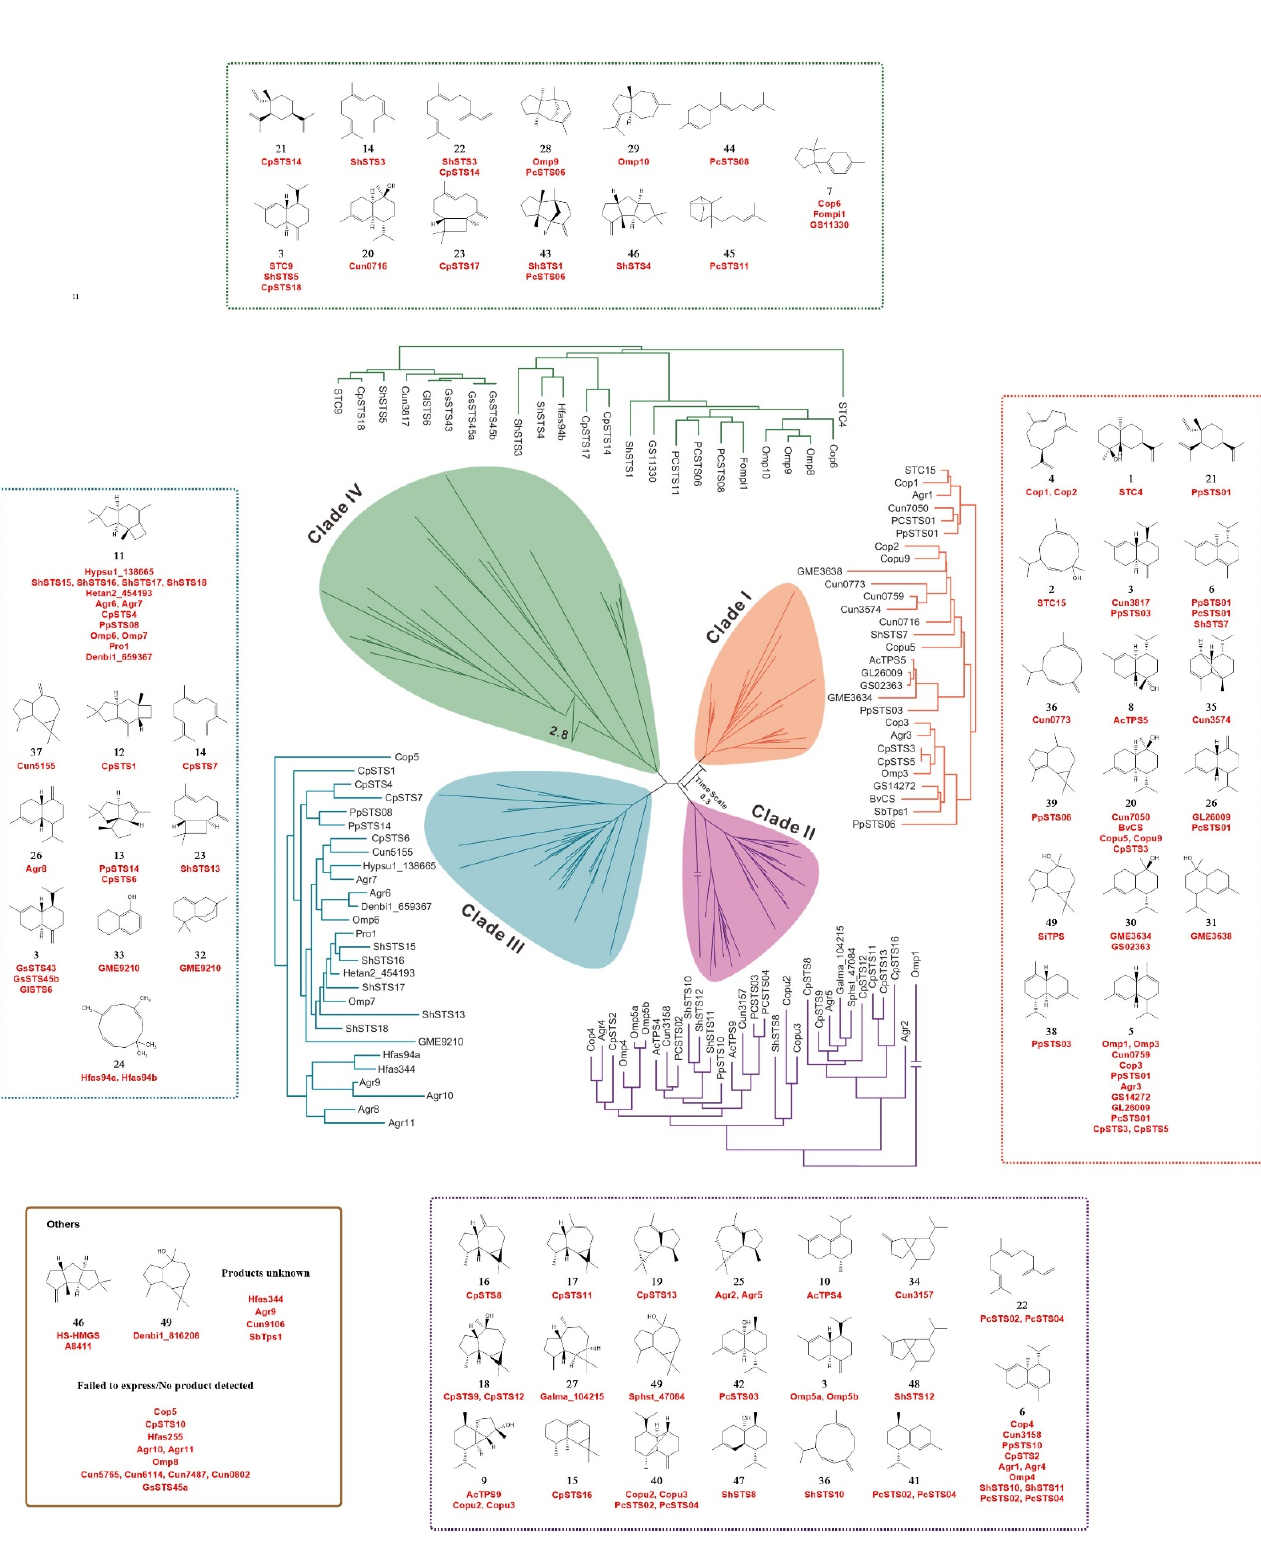
Figure 3. Sesquiterpene biosynthesis by STS of clades I–IV in basidiomycetes. All mentioned STSs have undergone biochemical verification.